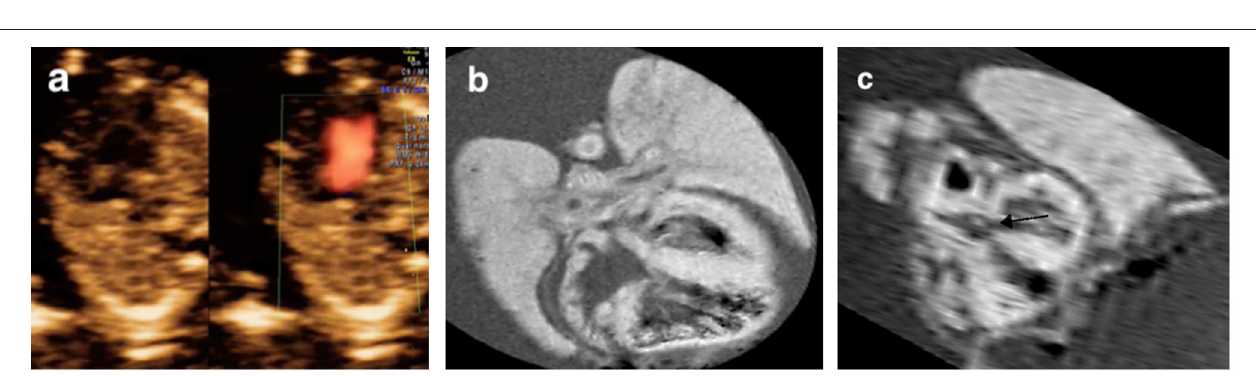
FIGURE 6 | Discordant findings of postmortem MRI compared with prenatal ultrasound. (a) A fetus presented with an AVSD on the four-chamber view and was terminated at 13 + 0 gestational weeks (Case 1 in Table 2 ). Postmortem MRI showed intact atrioventricular septal (b) and left ventricle outflow tract showed malalignment ventricular septal defect ( c , black